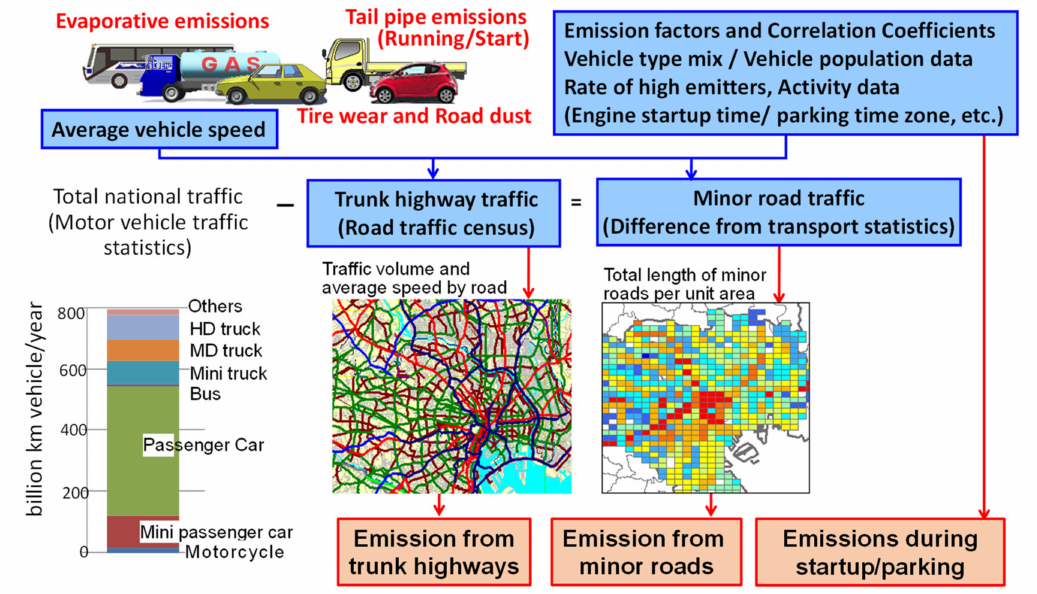
Figure 5. Conceptual diagram of JATOP Emission Inventory-Vehicle Emission Model (JEI-VEM), automobile emission